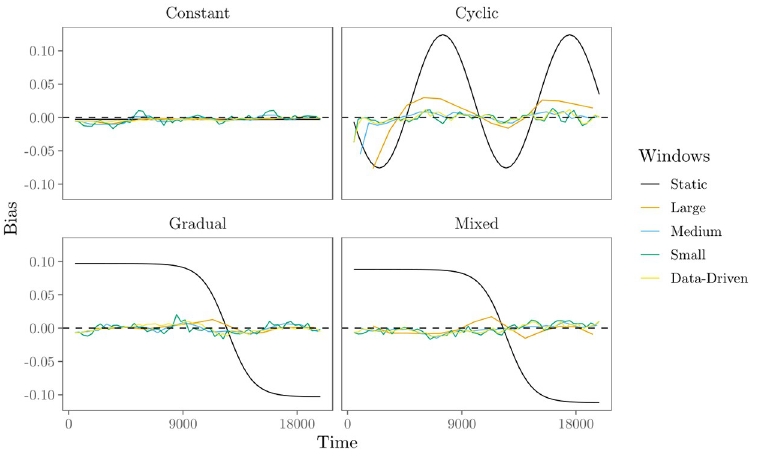
Fig 5. Bias for the ‘transitivity’ effect in the evaluation of the moving window REM. Panels refer to the four time- varying effect scenarios. Solid lines represent the bias of the parameter estimates over time, with colors representing estimation with large (4000 t ), medium (2000 t ), small (1000 t ) and data-based window widths.